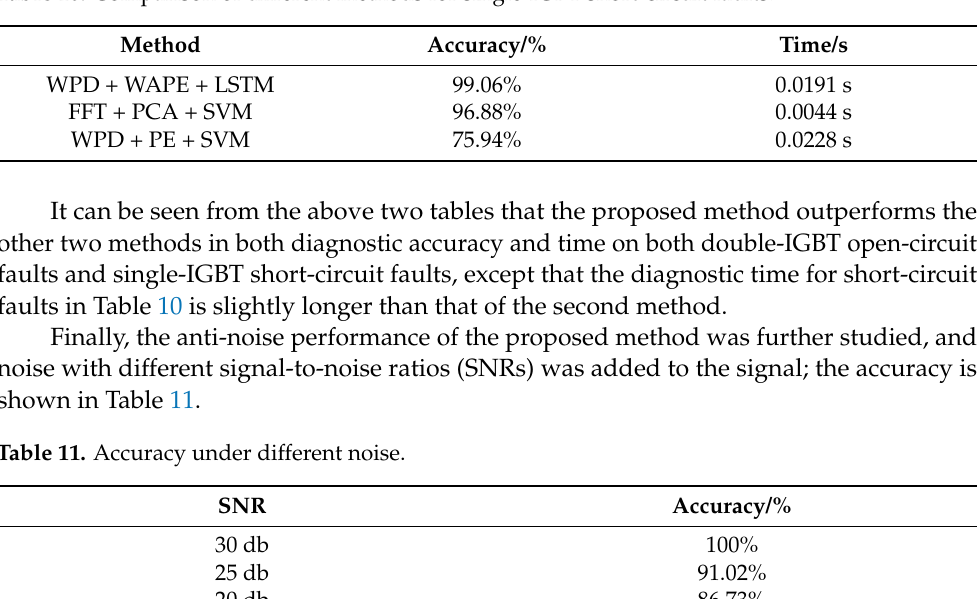
Table 10. Comparison of different methods for single-IGBT short-circuit faults.